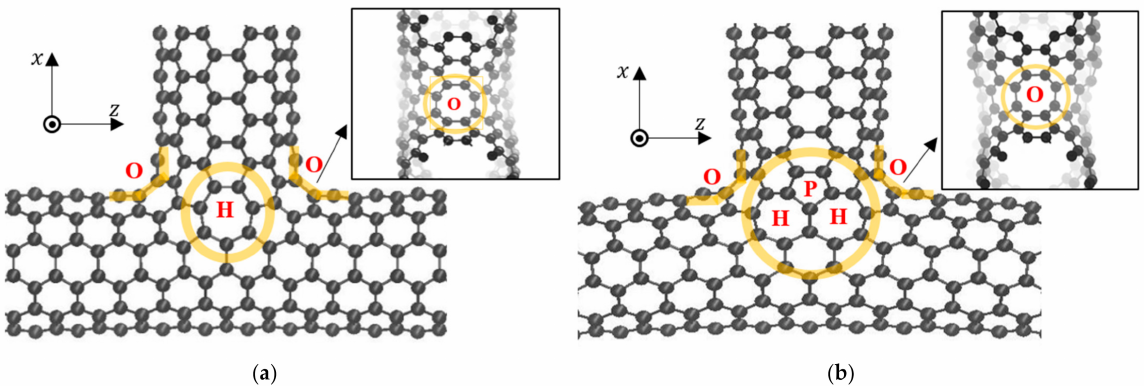
Figure 1. Atomic configurations of the two T-junctions: ( a ) T-junction 1 and ( b ) T-junction 2 (P, H, and O represent pentagons, heptagons, and octagons, respectively).